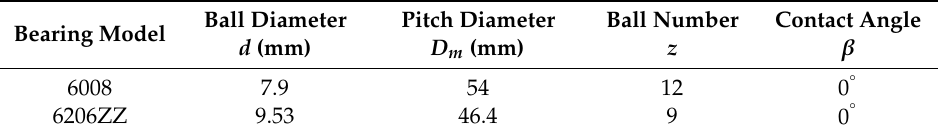
Table 1. The structural parameters of the faulty bearing.